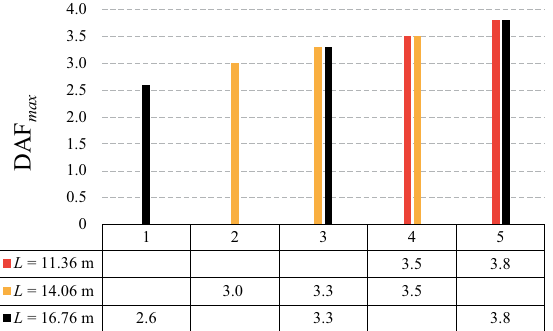
Figure 7. Pre-stressed string reinforced concrete beams without